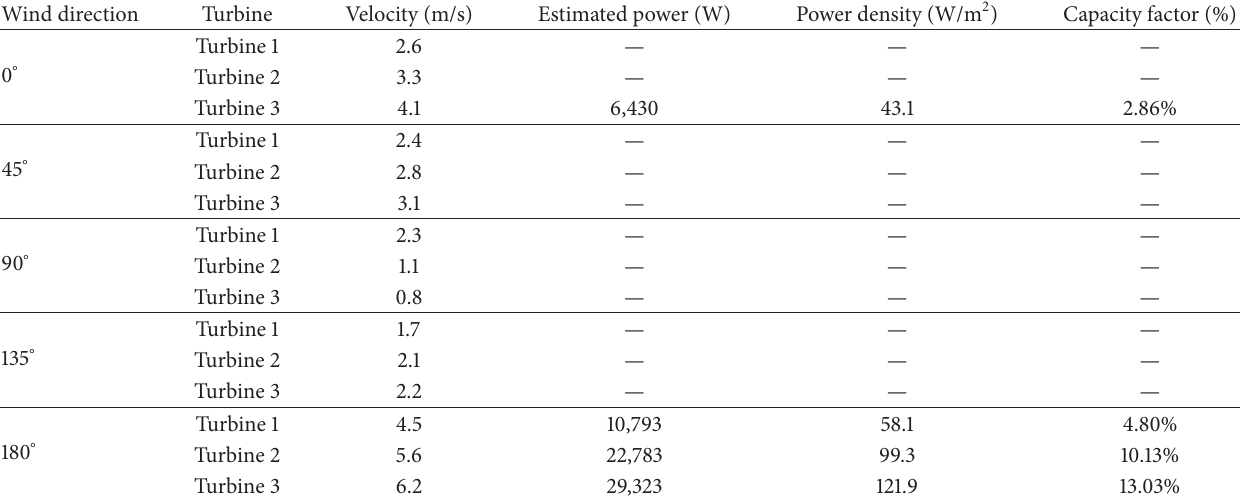
Table 2: Estimated power density and capacity factor at varying wind